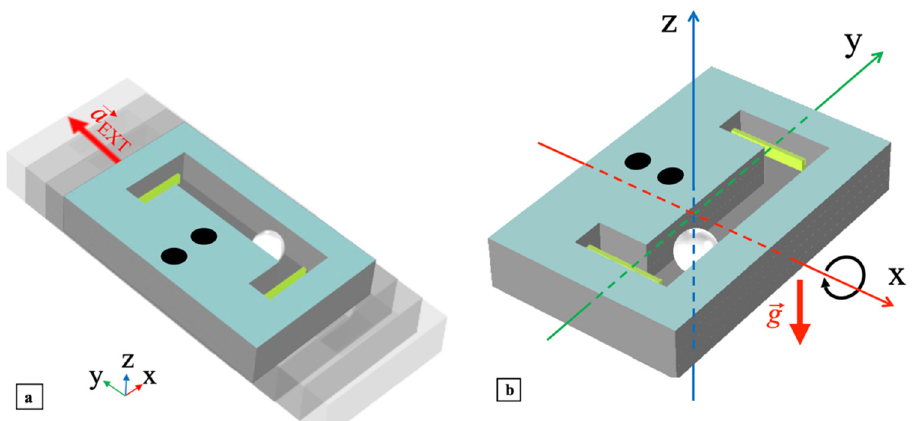
Figure 2. Excitations to which the mono-axial harvester is sensitive: shake applied along the y-axis ( a ) and tilt around the x-axis ( b ).